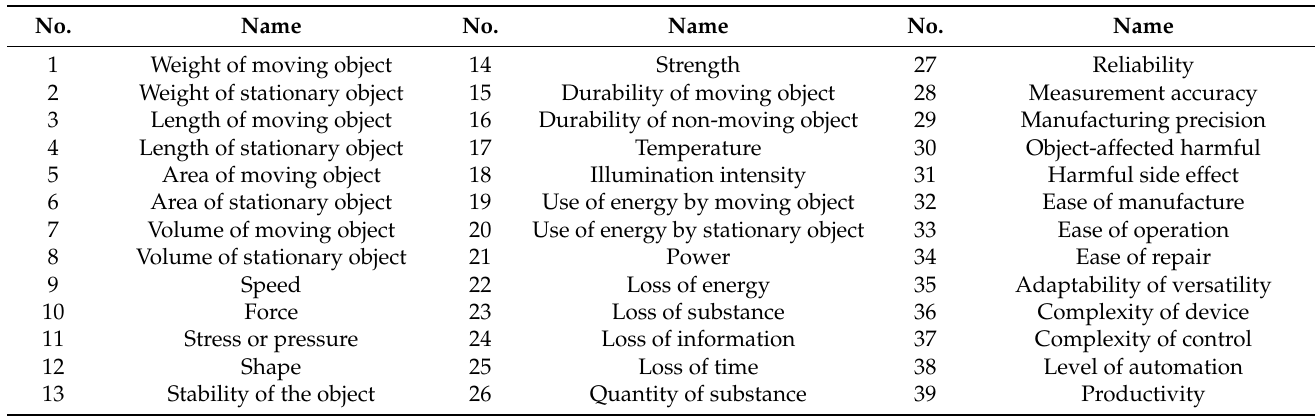
Table 1. 39 Engineering